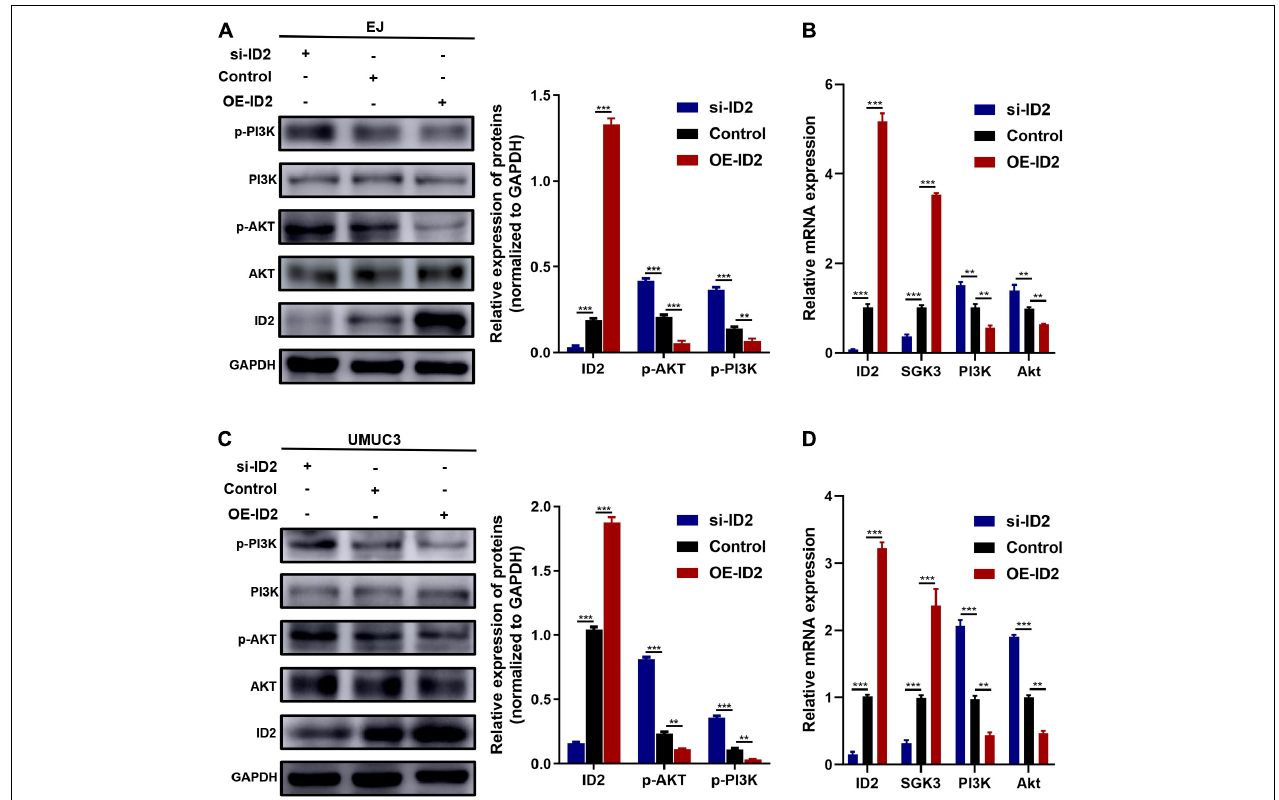
FIGURE 6 | Protein and mRNA changes in EJ and UMUC3 cells after transfection with si-ID2, NC-ID2 and OE-ID2. (A,B) Protein and mRNA changes in EJ cells. (C,D) Protein and mRNA changes in UMUC3 cell (** p < 0.01, *** p <